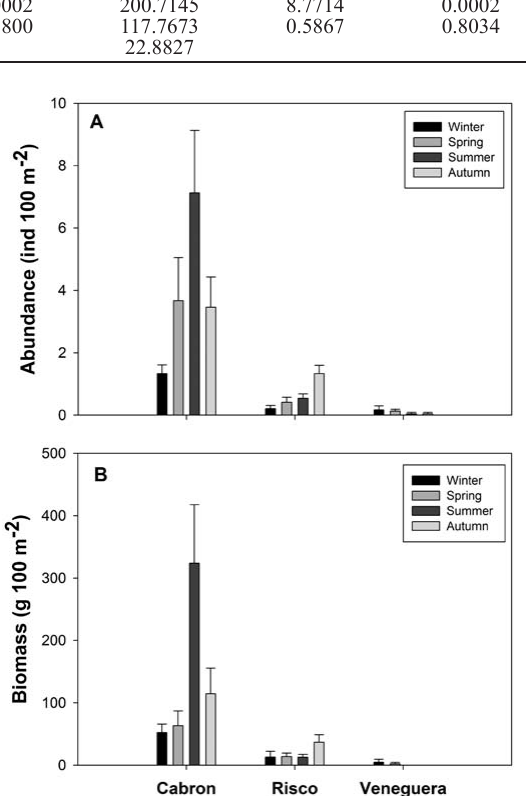
Fig. 2. – Mean abundance (A) and mean biomass (B) of the pearly razorfish, Xyrichtys novacula , at each location and time, recorded through the UVCs. Error bars indicate standard error of the